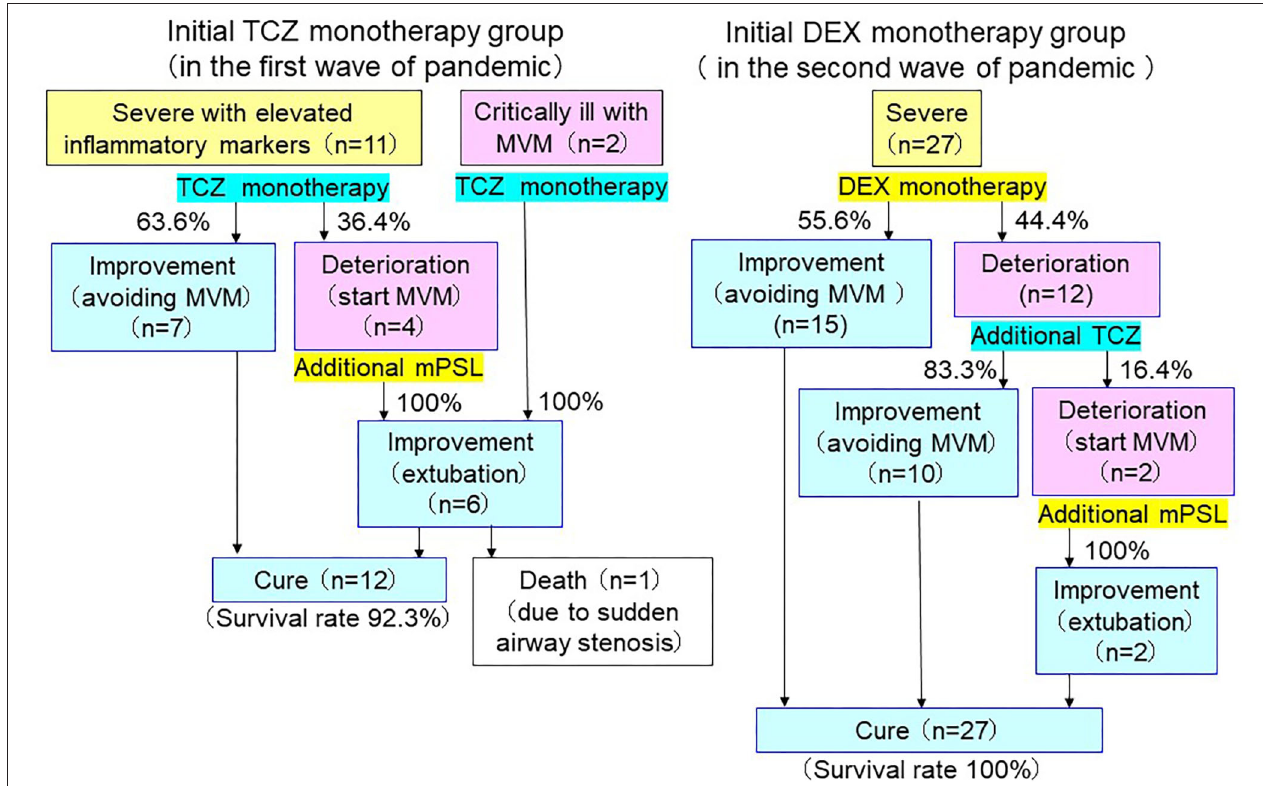
FIGURE 5 | Clinical outcomes of severe-to-critically ill COVID-19. Both 7 of 11 patients (63.6%), who received tocilizumab (TCZ) monotherapy and 10 of 12 patients (83.3%), who received additional tocilizumab after rapid deterioration with dexamethasone (DEX) monotherapy were able to avoid mechanical ventilation management (MVM). Two patients, who received tocilizumab monotherapy under MVM were able to recover from MVM. However, 5 of 6 patients, who deteriorated even after single or additional tocilizumab administration and required MVM, improved with additional methylprednisolone (mPSL) treatment, and a total of 39 of 40 were cured (survival rate